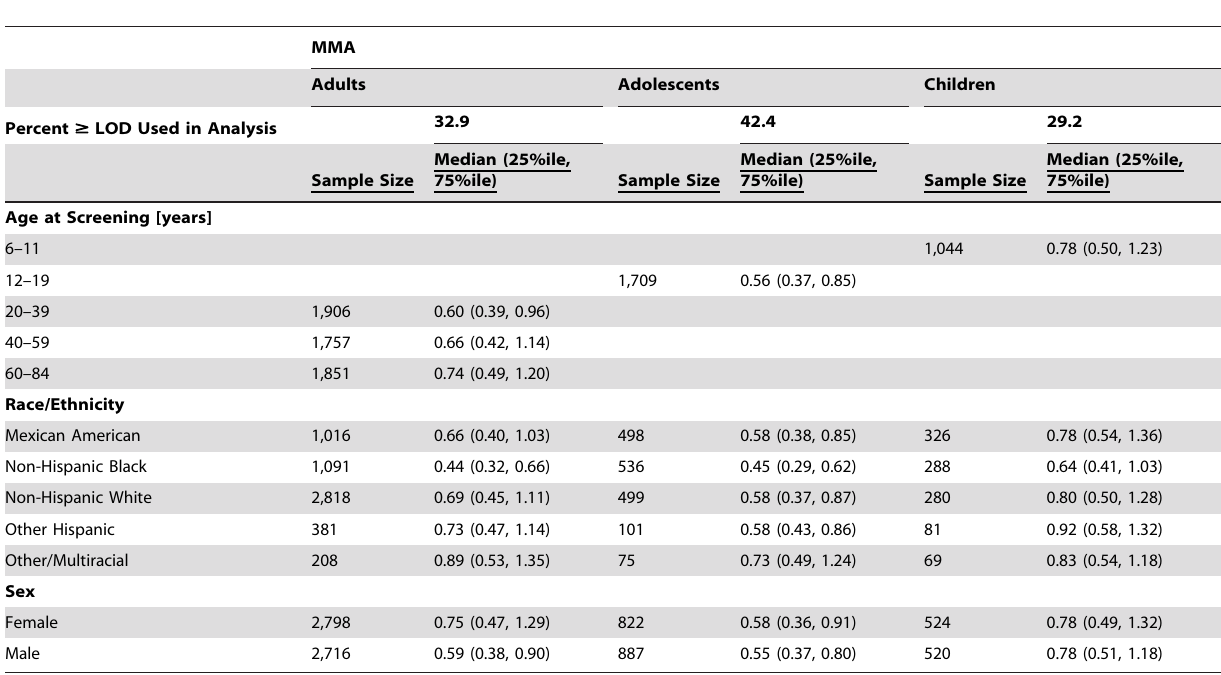
Table 3. Sample-weighted 25 th , 50 th , and 75 th percentiles for creatinine-adjusted urinary MMA [ m mol/mol Cre] for NHANES 2003– 2010 data used in the regression models displayed in Tables 3 and